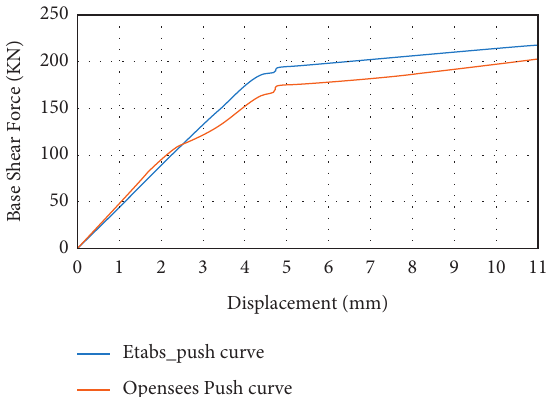
Figure 19: Results obtained from eccentric frame modeling in OpenSees and ETabs